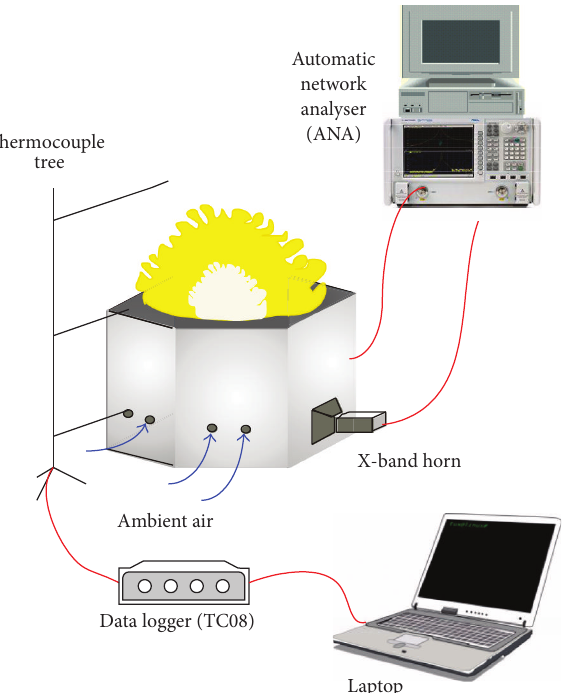
Figure 1: Automatic network analyser set up for scattering parame- ters